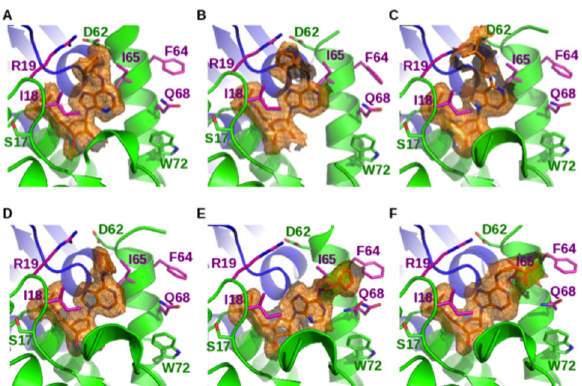
Figure 6. The active site of the DNPH1 structures in complex with nucleotides N 6 -cyclopentyl AMP (A, D), N 6 -furfuryl AMP (B, E) and N 6 -isopentenyl AMP (C, F). The ligand conformers correspond to two independent monomers in the crystal structures of rat DNPH1 in the monoclinic forms (this study; panels A, B, C, E, and F) and the previously published orthorhombic form (PDB4FYI) in the first panel D). Omit maps were computed by omitting the ligand at the last refinement step before computing the electron density. The density of the bound ligands were contoured at the 1.0 s level and shown as orange surfaces and meshes. Backbones are represented as ribbons (front monomer in green and back monomer in blue) and ligands as sticks. Important side chains were drawn as sticks. Side chains contacting the N 6 -substituents (I18, R19, F64, I65 and Q68) are shown in pink and some other residues that make up the active site (S17, D62, W72) are in green. The figures were generated by Pymol (www.pymol.org). doi: